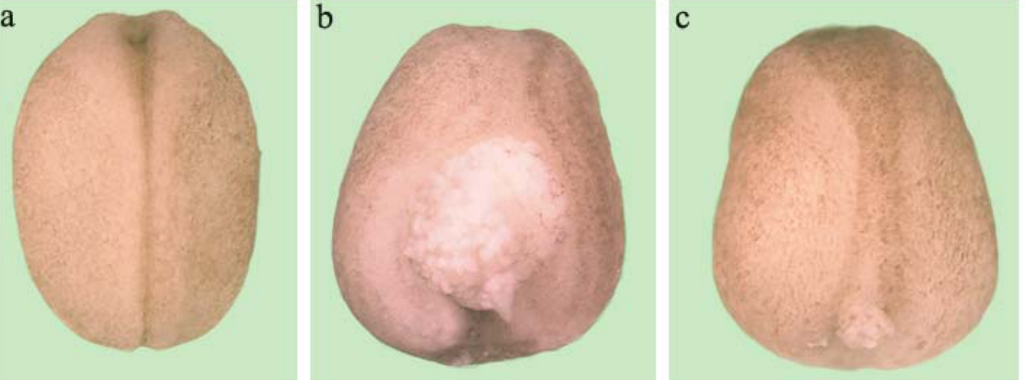
FIGURE 1. xSyn4 is essential for CE. Microinjection of morpholinos for xSyn4 (xSyn4MO) caused severe defects in gastrulation and neural tube closure in contrast with control embryos (a). The phenotypes induced by xSyn4MO were classified into those with severe gastrulation defects (b) and those with only neural tube closure defects (c).